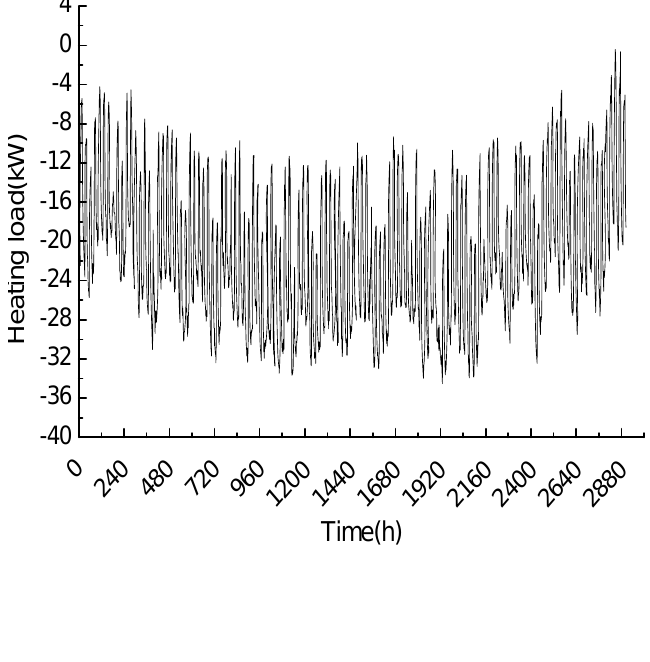
Figure 3. The heating load of the building during winter